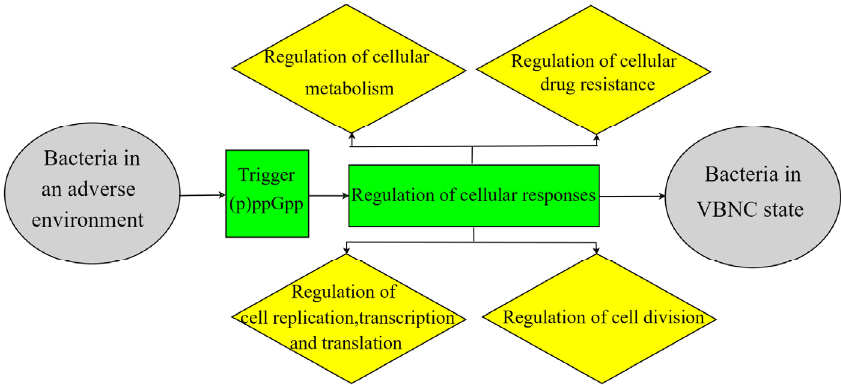
Figure 2. Schematic diagram of stringent response theory.